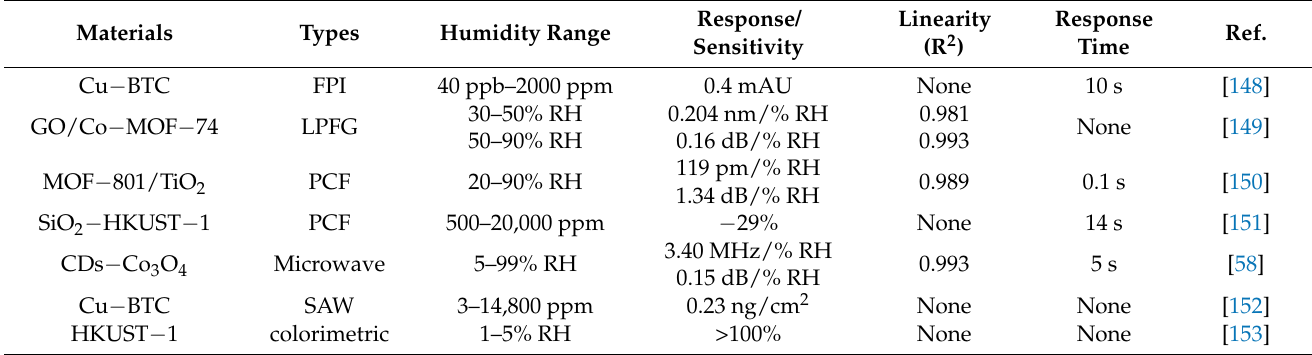
Table 6. Sensing properties of other MOF − based types of humidity